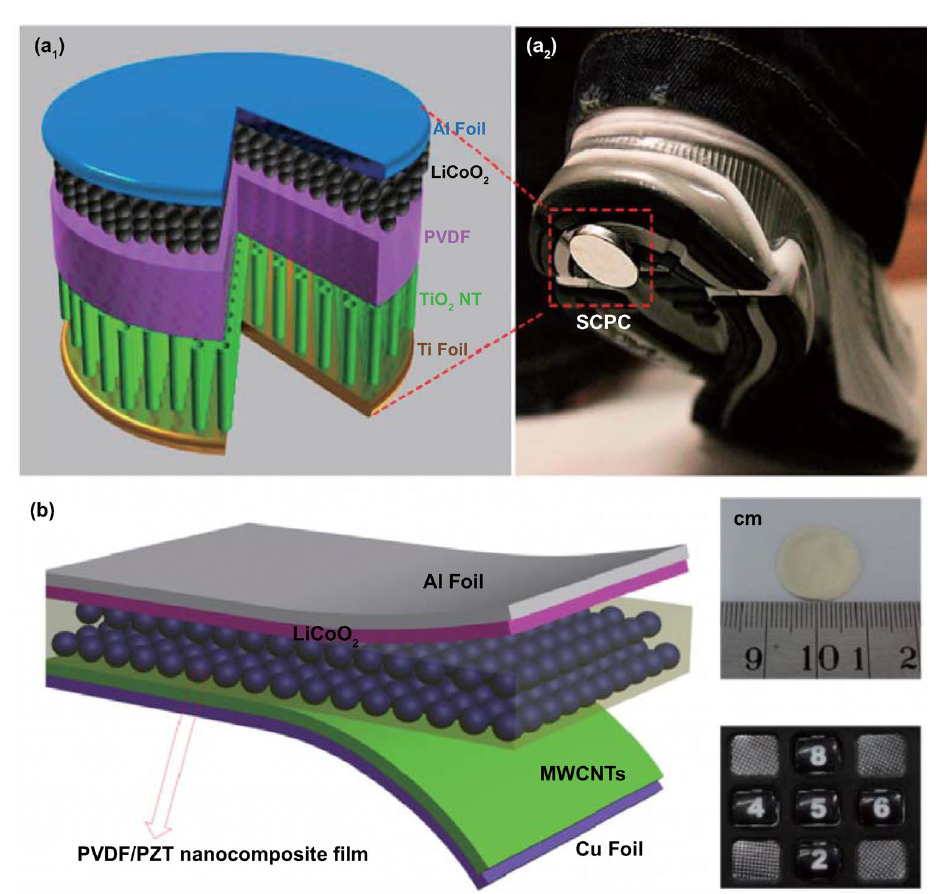
Fig. 9 a Schematic showing the design and structure of the self‑charging power cell. This structure is sealed in stainless steel 2016‑coin‑type cells, as shown in the inset. On adhering a power cell to the bottom of a shoe, the compressive stress generated by walking can be converted and stored directly by SCPC. Reproduced with permission [44]. Copyright 2012, American Chemical Society. b Schematic structure of a SCPC with a PVDF–PZT nanocomposite film as a piezo‑separator for charge storage. Photograph of PVDF–PZT nanocomposite film. Adhering an SCPC underneath the button of a calculator, the mechanical energy generated by pressing the button can be converted and directly stored by the SCPC. Reproduced with permission [181]. Copyright 2014, IOP Publishing